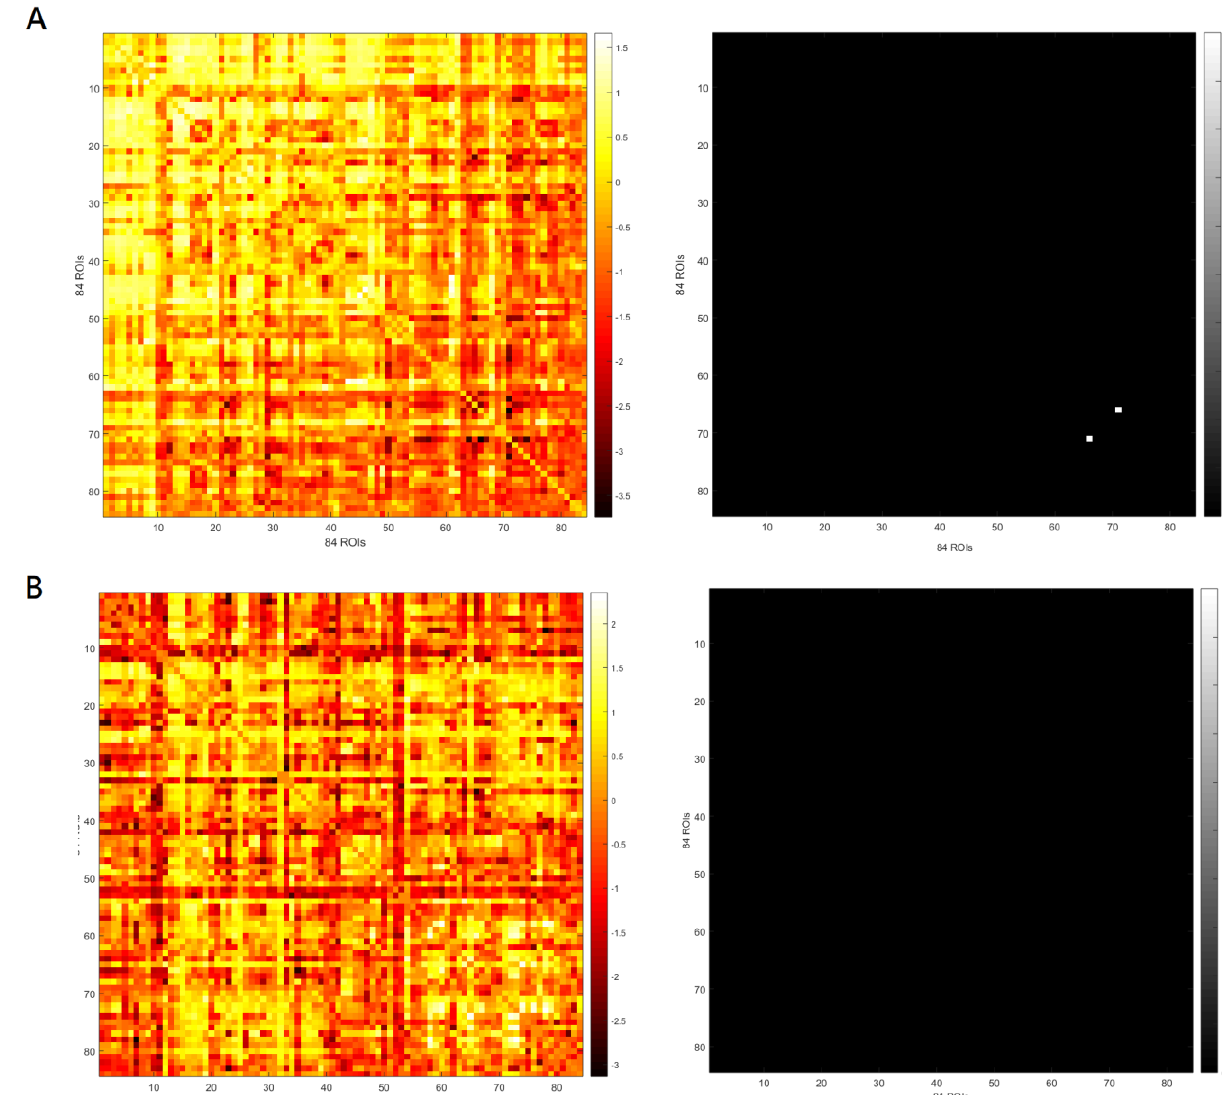
Figure 3. The left panels indicate the matrix of the t value for the mean change for lagged phase synchronization (LPS) of any pair of 84 regions of interest (ROIs) from baseline to the end of stimulation ( A ) and from baseline to the one-week follow-up ( B ). The right panels indicate the maps where t values in the matrix of the left panels that are greater than t -value threshold for statistical significance return 1 and those less than the threshold return 0.